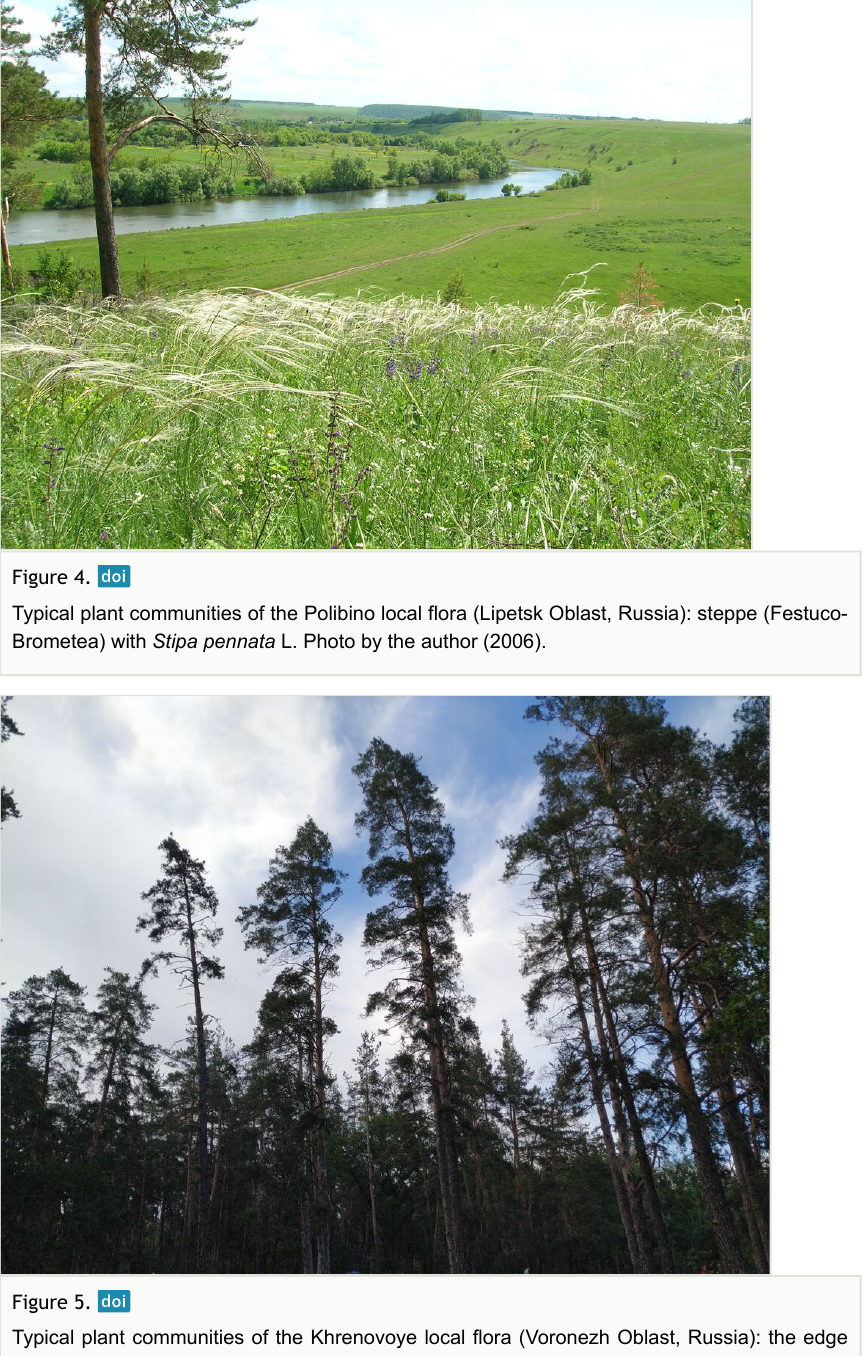
Typical plant communities of the Khrenovoye local flora (Voronezh Oblast, Russia): the edge of thermophilous pine forest (Pyrolo-Pinetea). Photo by the author